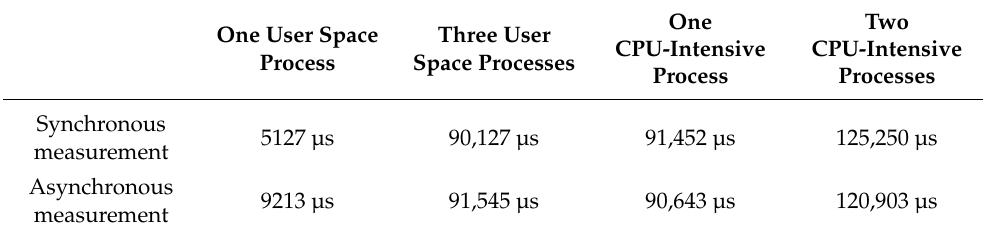
Table 1. Latency measurements using a micro:bit device.